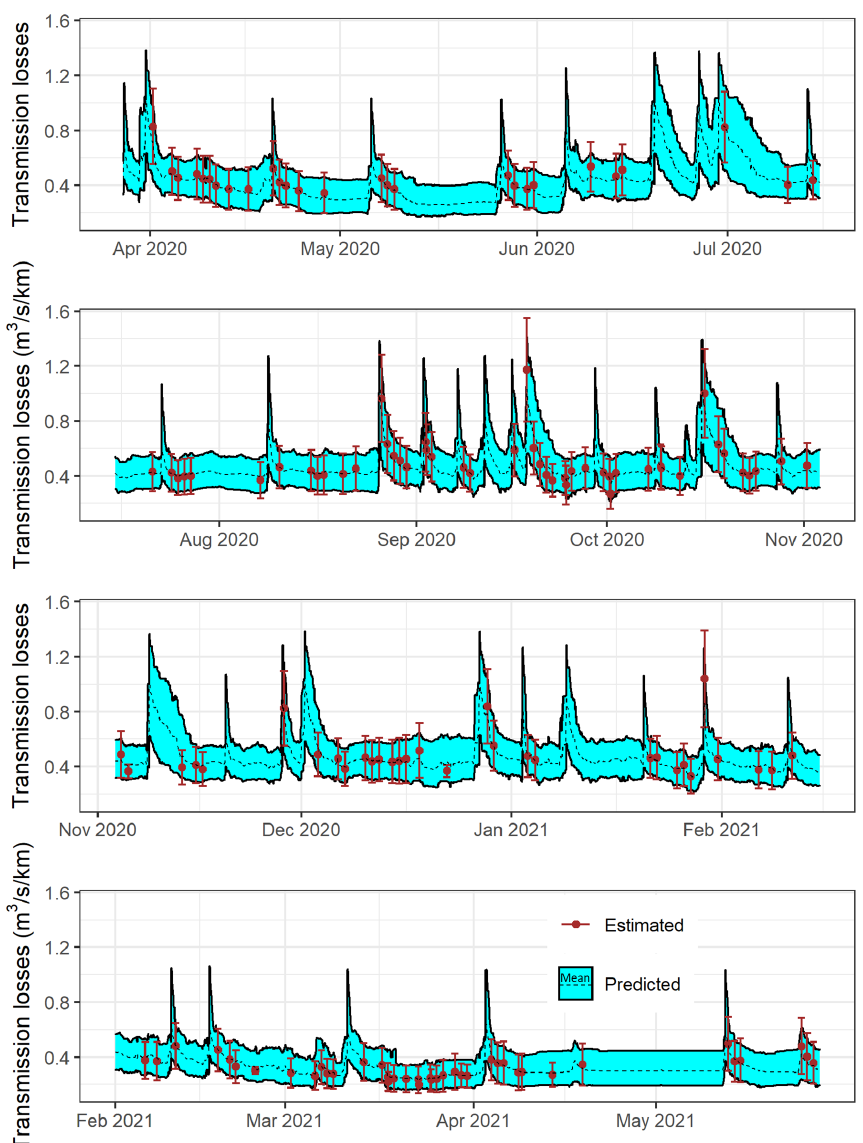
Figure 12. Transmission loss time series predicted (cyan) using the random forest models trained on the transmission loss data points estimated (orange) using field data and satellite